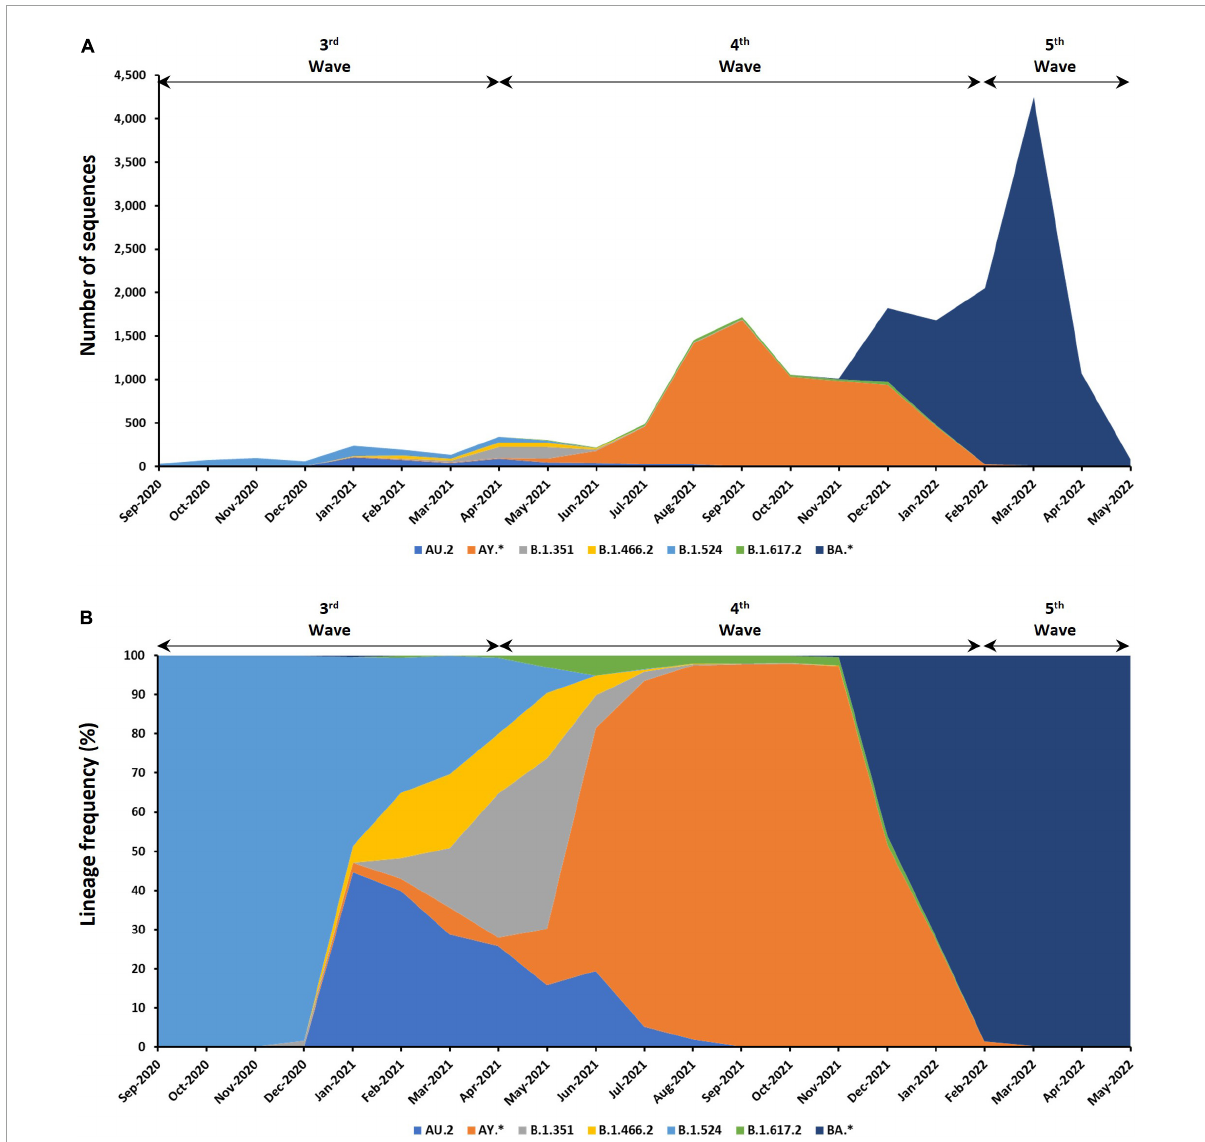
FIGURE4 Distribution of lineages among the 9,468 genomic sequences in Malaysia. (A) Number of sequences based on lineages. (B) Distribution of lineage frequency. Only lineages with more than a total of 100 sequences are presented. *Indicates all descendent